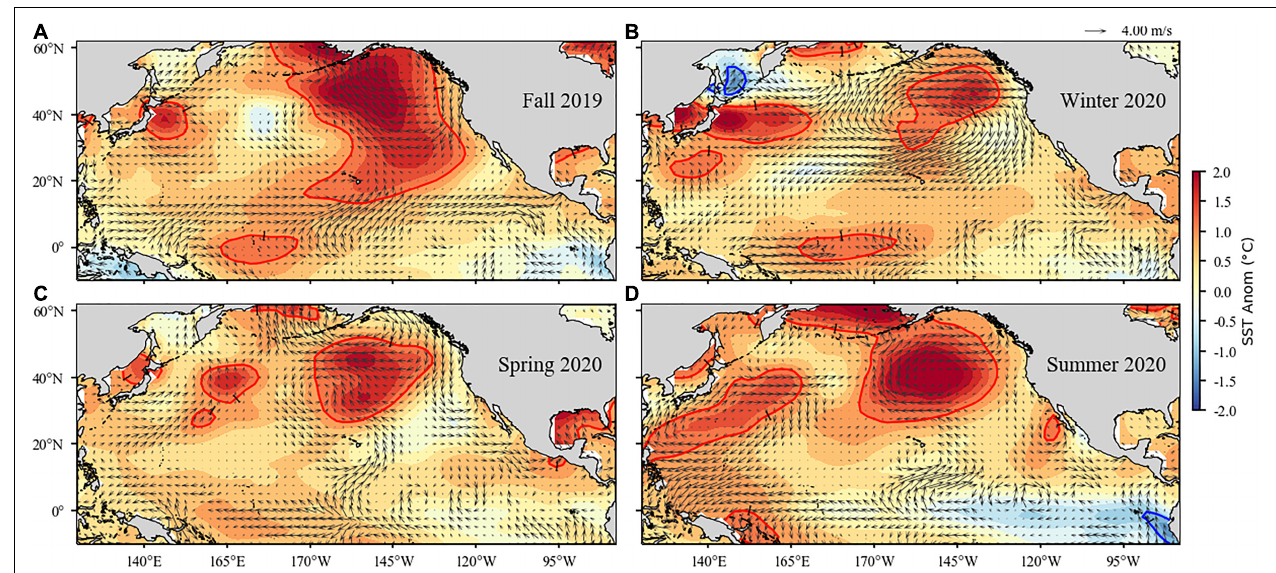
FIGURE 3 | Surface wind velocity and sea surface temperature anomalies in the North Pacific Ocean for fall (September–November) 2019 (A) , winter (December–February) 2020 (B) , spring (March–May) 2020 (C) , and summer (June–August) 2020 (D) . Arrows denote magnitude and direction of wind anomaly (scale arrow at top). Contours denote temperature anomaly. Shading interval is 0.25 ◦ C and contour intervals at ± 1 ◦ C are shown in red and blue, respectively. Climatology period is 1980–2010 for both data